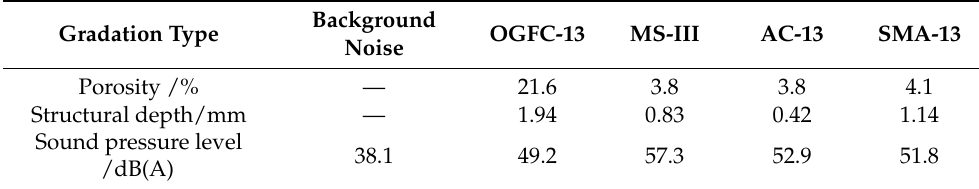
Table 9. Measurement and analysis results of different pavement noises.